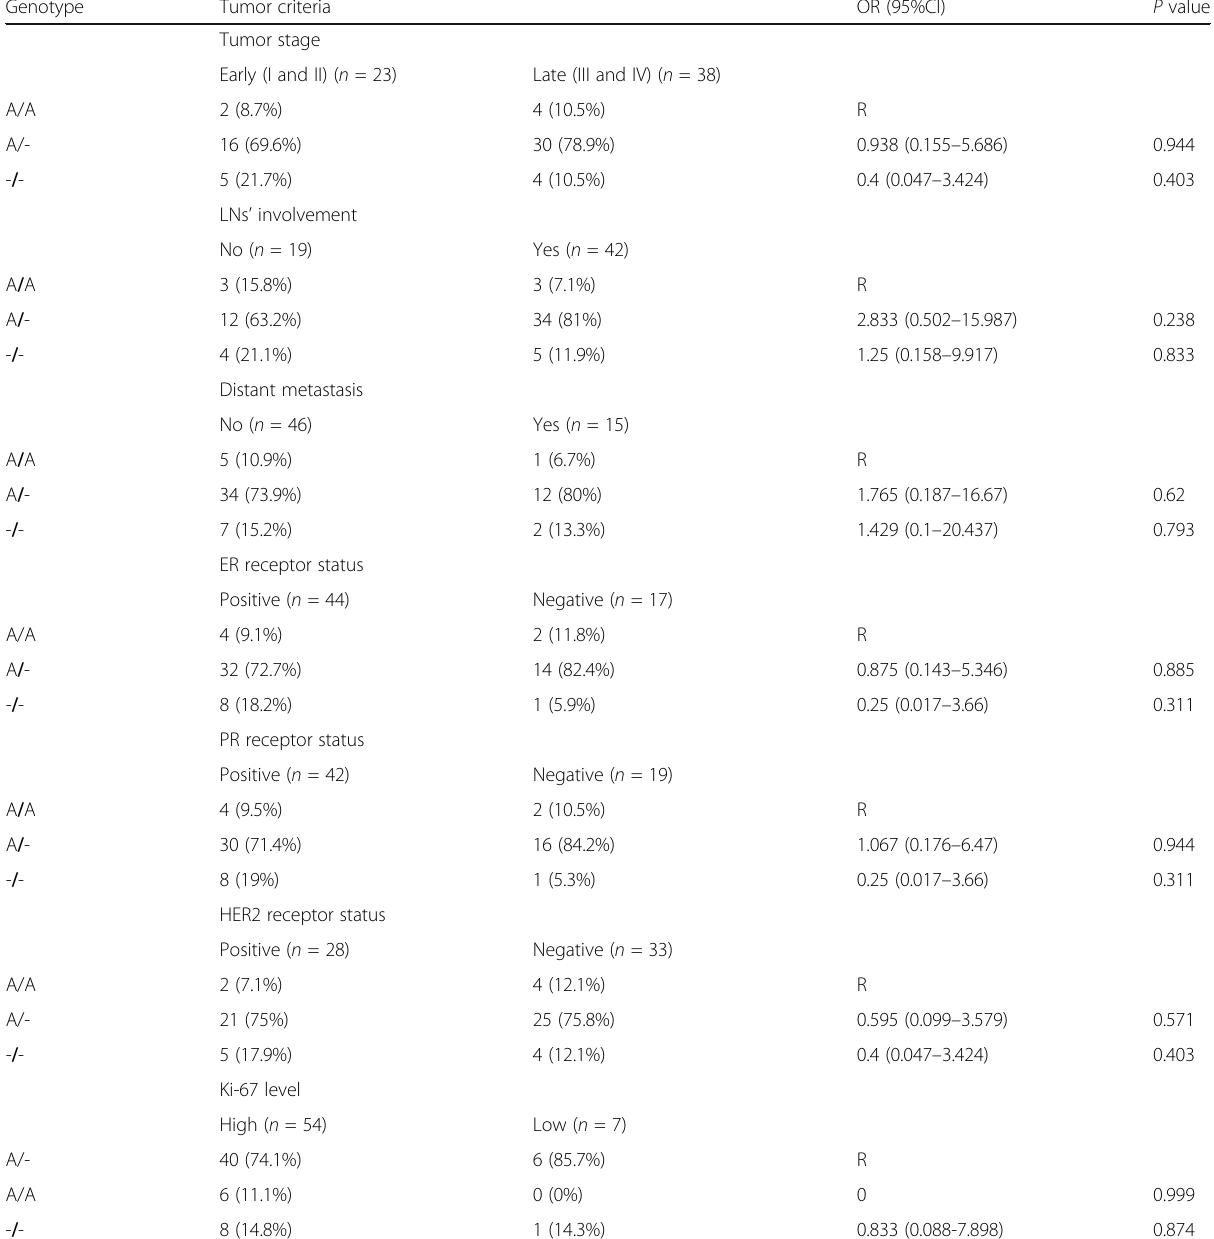
Table 5 Association between genotypes of KISS1 rs5780218 polymorphism and tumor criteria in the breast cancer group